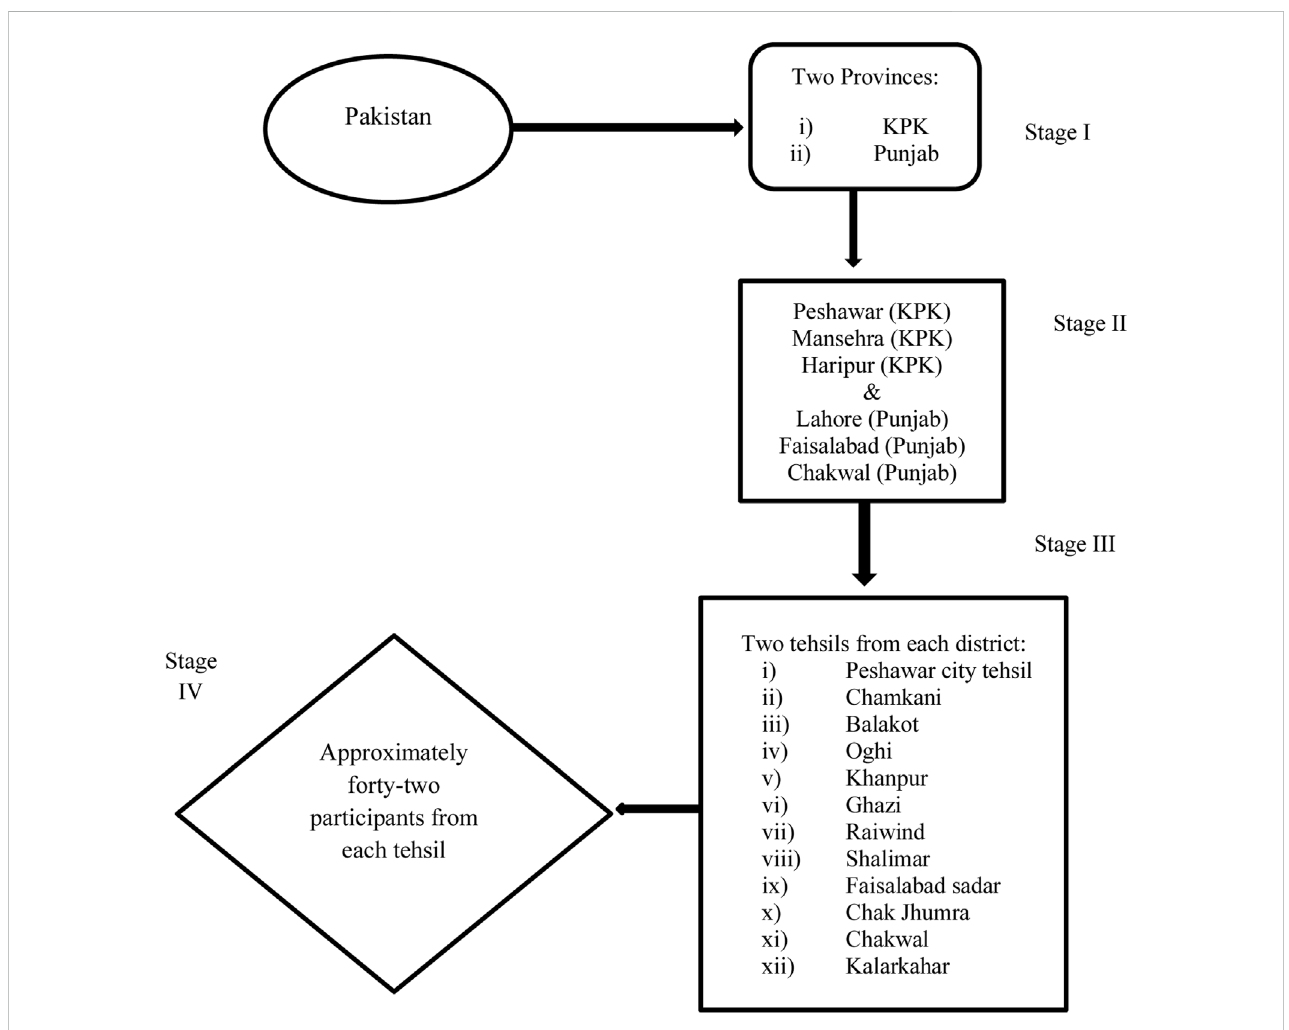
FIGURE 3 Stages of sampling to select